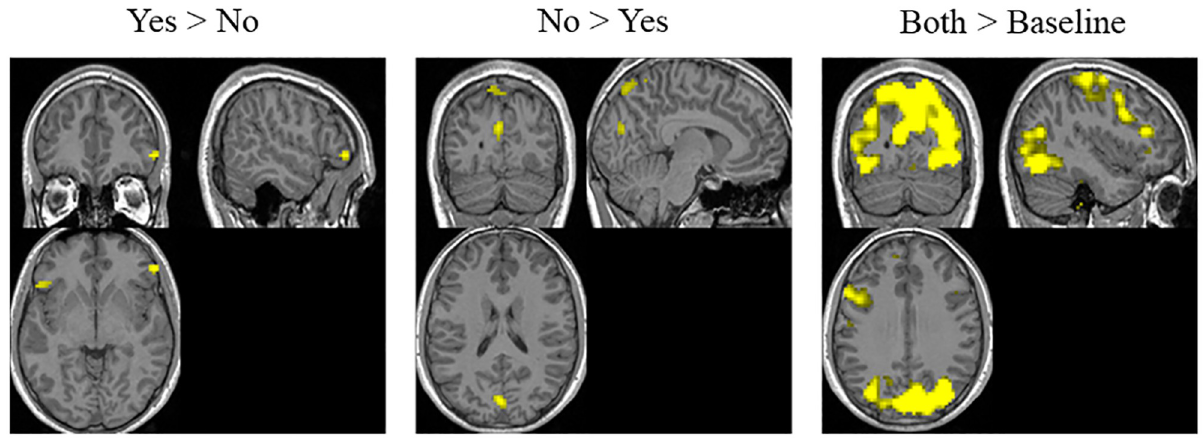
Fig 3. Spatial regions corresponding to different contrasts in the GLM